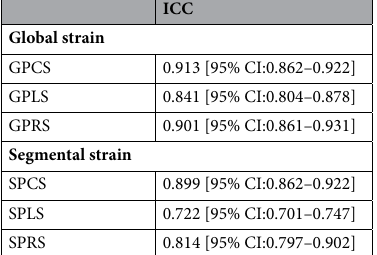
Segmental longitudinal strain. Among the patient population mean segmental peak longitudinal strain (SPLS) was mildly impaired in subendocardially (− 7.5% ± 8) and transmurally (− 5.9% ± 7) infarcted segments com- pared to mean SPLS of remote myocardium (− 12.8% ± 3, p = 0.3 and 0.4) (Fig. 3). Interobserver agreement was moderate (Table 2). Segmental radial strain. Mean segmental peak radial strain (SPRS) was mildly impaired in subendocardially infarcted segments in the patient cohort (18.9% ± 10), but significantly impeded in transmurally infarcted seg- ments (15.9% ± 6) compared to SPRS of remote myocardium (31.4% ± 5; p = 0.3 and 0.02) (Fig. 3), interobserver agreement was good (Table 2). The optimal cut-off value for SPRS for discriminating scar tissue from remote myocardium was 16.6% with a sensitivity of 83.3% and specificity of 76.5%, AUC 0.86 [0.827–0.902] (Fig. 4, right image). Localization of infarcted segments in circumferential strain calculations and by visual wall motion assess- ment. Localization of potentially infarcted segments based on segmental circumferential strain calculations (endo-/epicardially contoured short axis cine images and resulting polar plot strain map, Fig. 1) revealed 118 infarcted segments from 147 infarcted segments (80.3%, 88 transmural, 30 subendocardial; Fig. 5) with excel- lent interobserver agreement (ICC 0.904, 95%CI 0.845–0.933). 29 infarcted segments were not detected (24